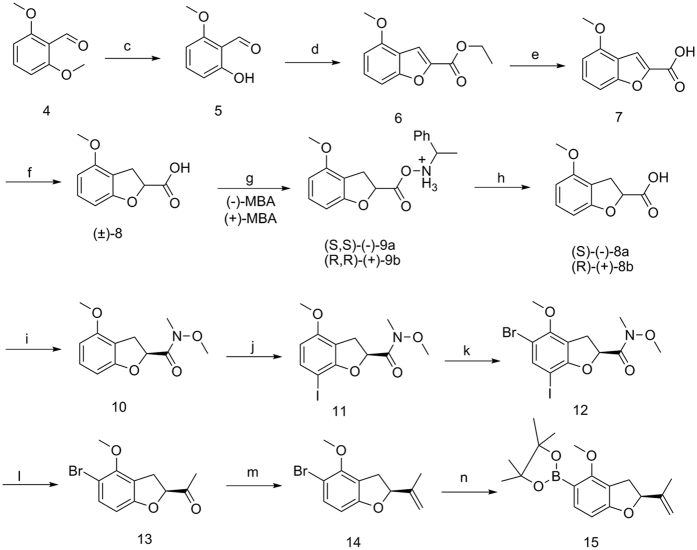
Synthesis of intermediate 15.Reagents and conditions: (c) NaI, AlCl3, MeCN, DCM, 0 °C; (d) BrEA, K2CO3, DMF, 140 °C; (e) MeOH, NaOH, 100 °C; (f) MeOH, Mg, rt; (g) Me2CO, (+)-α-MBA, (-)-α-MBA; (h) water, EtOAc, 5 N HCl (aq), 0 °C; (i) DCM, CDI, H•HCl, rt; (j) TCM, I2, silver triflate, rt; (k) THF, NBS, rt; (l) THF, MeBrMg, −10 °C; (m) (i) ether, iodomethane, KTB, 0 °C, (ii) 40 °C; (n) 1,4-dioxane, Pd(dppf)Cl2, KOAc, bis(pinacolato)diboron, 105 °C.